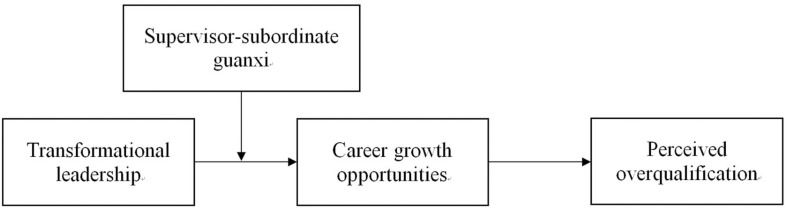
Theoretical model.